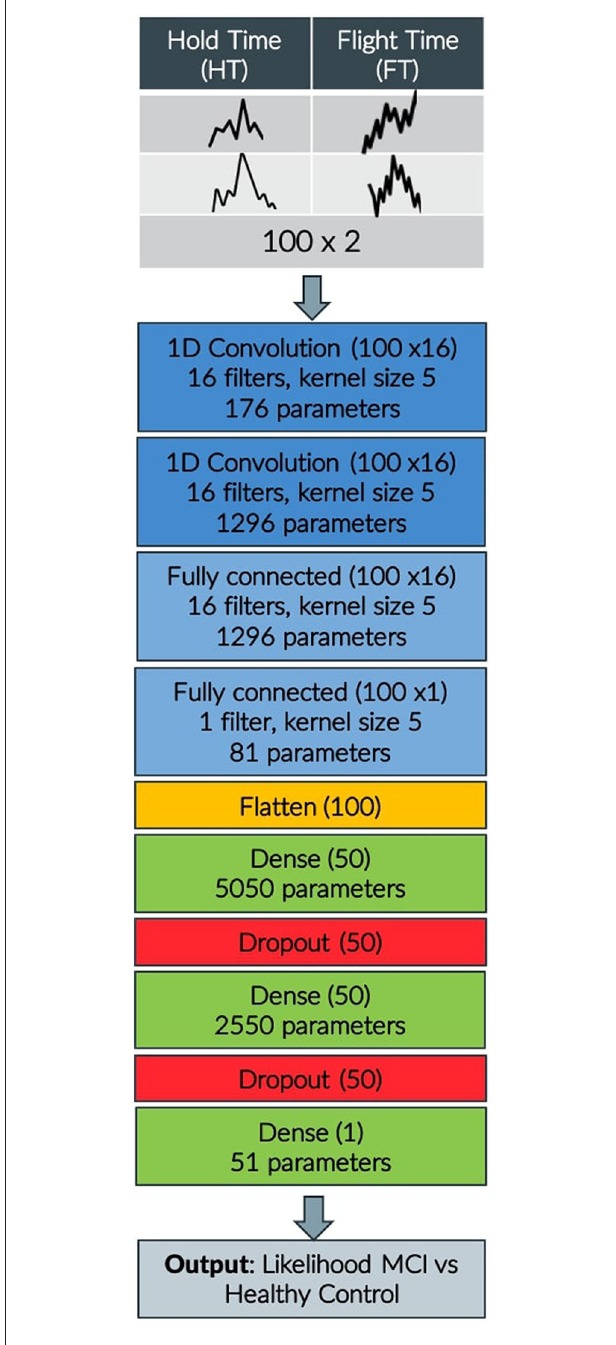
FIGURE 2 | CNN model layout indicating input, convolution, flattening, dense, and dropout layers, output shape of each layer and number of parameters.